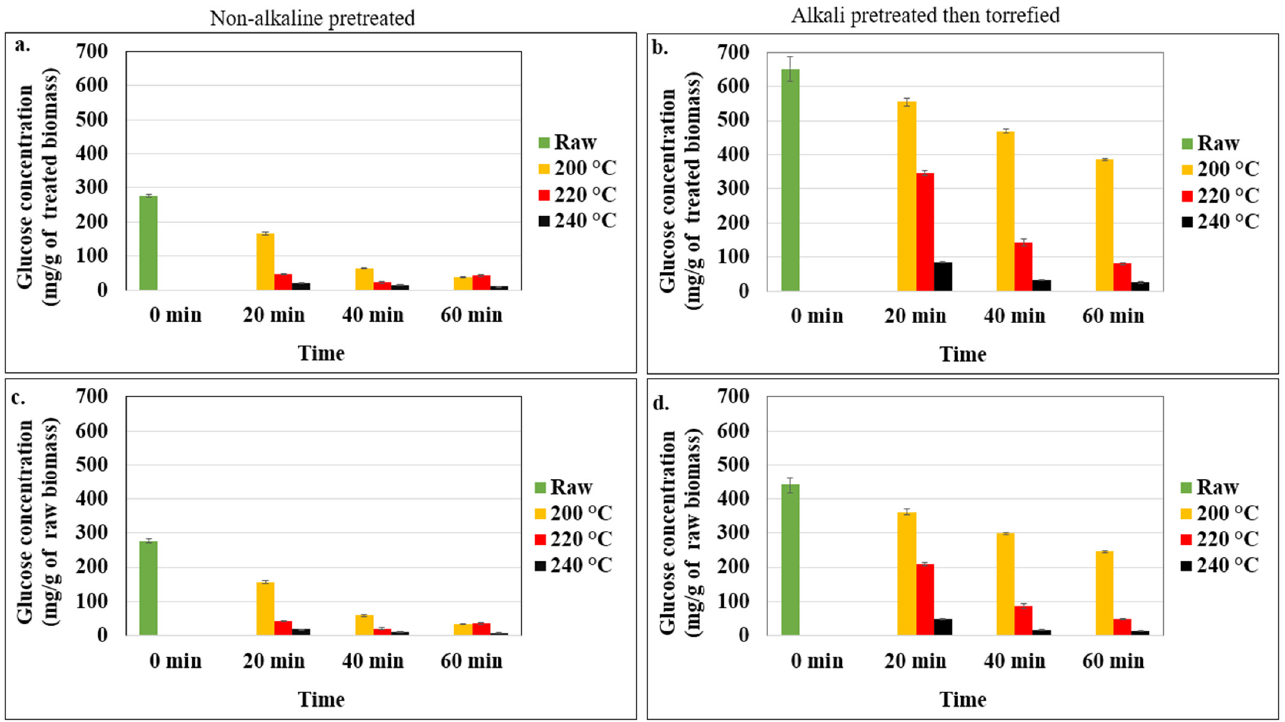
Figure 2. Glucose yield from samples torrefied at different temperatures and residence times without alkaline pretreatment and with alkaline pretreatment before torrefaction. ( a , b ). are expressed on the basis of “per unit mass of treated biomass”, whereas ( c , d ). are expressed on the basis of “per unit mass of raw biomass”. Table 2. Tukey’s HSD results for identifying significantly different pairs.